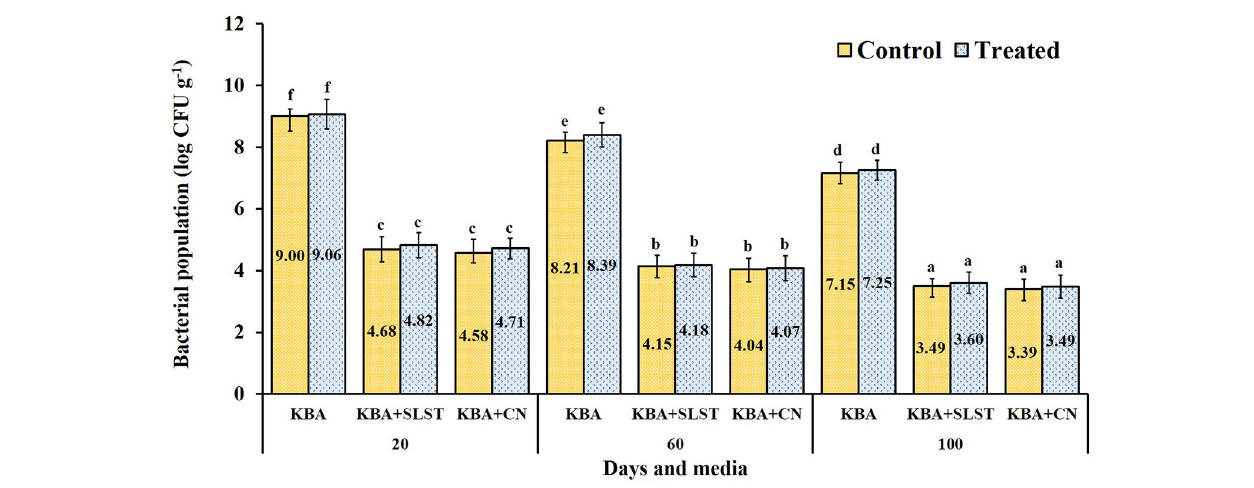
FIGURE 2 | Cultivable rhizobacteria isolated from rhizosphere samples of treated and control finger millet. KBA–Kings B agar; KBA + SLST–Kings B agar + sodium lauroyl sarcosine + Trimethoprim (20 mg − 1 ); KBA + CN–Kings B agar + Cetrimide + nalidixic acid (15 µ g ml − 1 ). Each value represents the means ± SD of 5 replicates and within a column, different letters were assigned when significant according to HSD Tukey test ( P < 0.05).